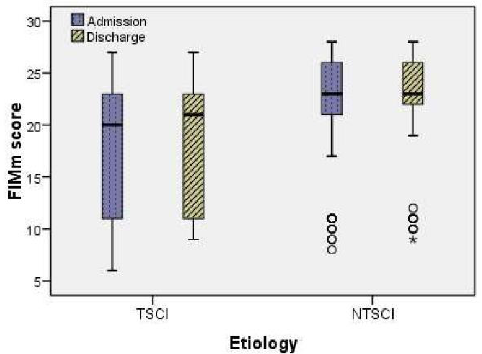
Figure 3. The distribution of VAS scores across categories of etiology (T-SCI/NT-SCI).